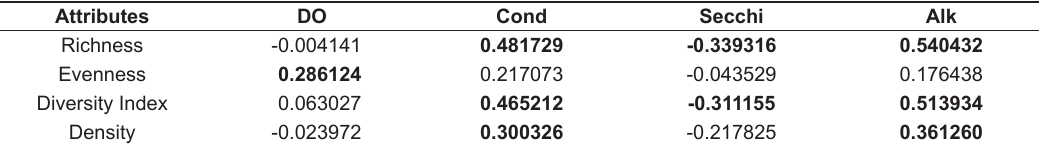
Table 3. Spearman correlation results between the abiotic variables and the Oligochaeta attributes. Attributes DO